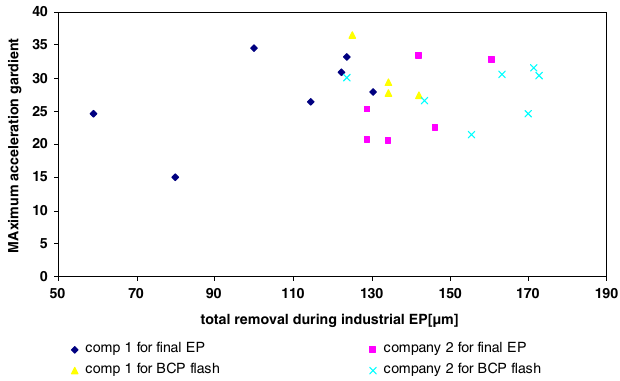
FIG. 4. (Color) Comparison of maximum acceleration gradient and removal of material during main EP treatment at industry.